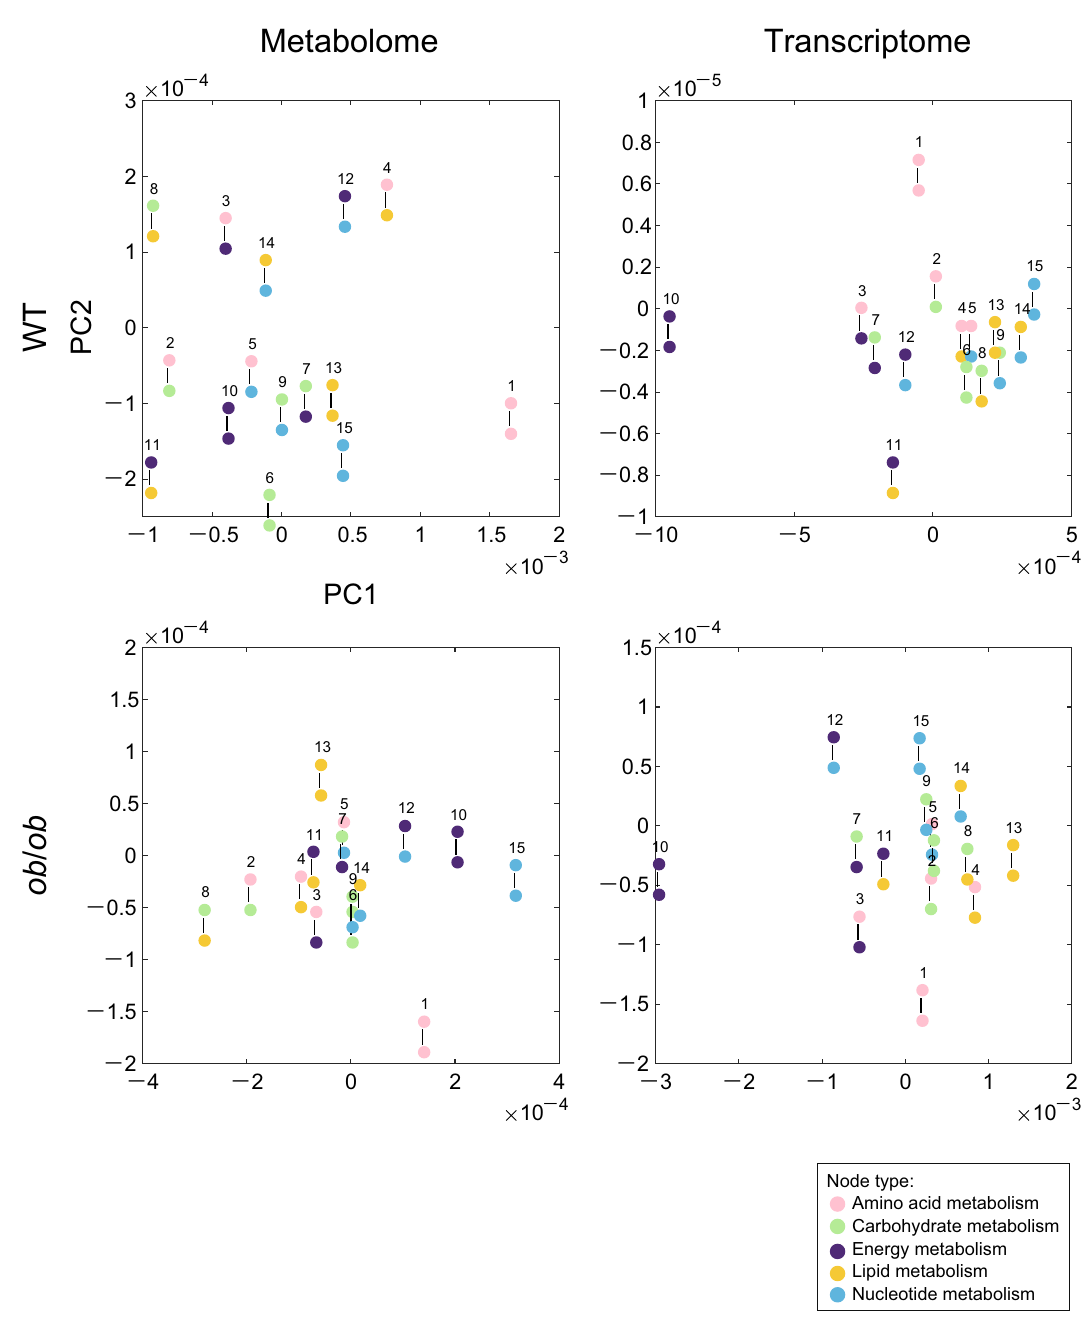
Figure 6. The MDS plot for the ETs. ETs are arranged according to Chi-squared histogram distance of the distributions of the OGTT response edges. The metabolome of WT (left upper panel) and ob / ob (left lower panel), the transcriptome of WT (right upper panel) and ob / ob (right lower